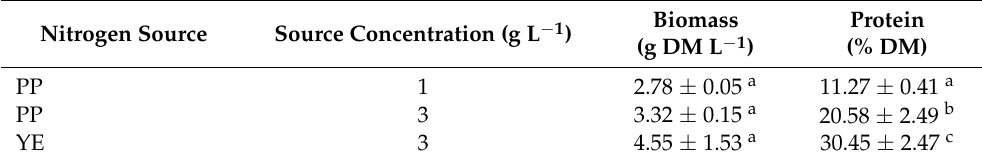
Table 3. Effect of nitrogen source and concentration on biomass production (g DM L − 1 ) and protein concentration (% DM) in biomass using modified Bristol as medium in batch bottle trials.